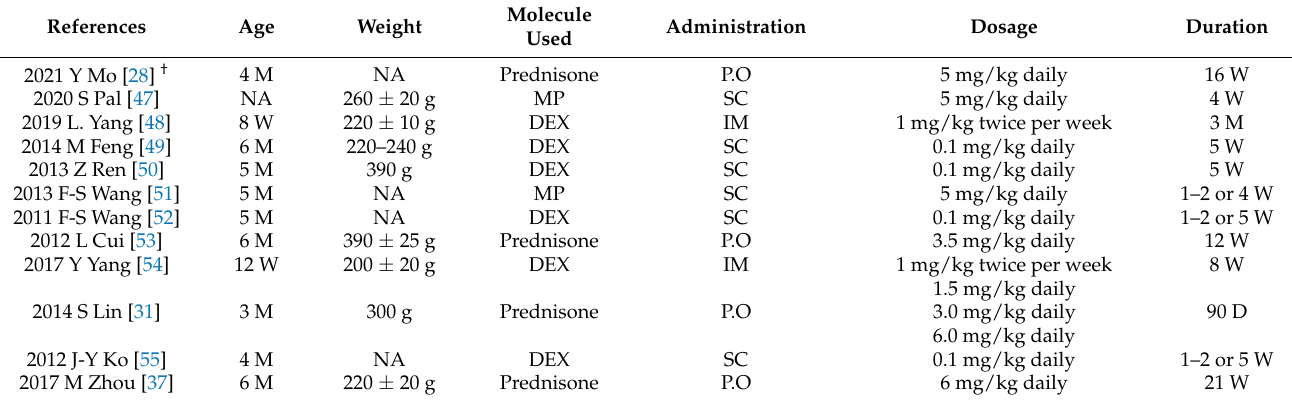
Table 4. Main characteristics of the proposed experimental protocol to induce GIOP in male Sprague Dawley. DEX = Dexamethasone, MP = Methylprednisolone, IM = Intramuscular injection, SC = Subcutaneous injection, P.O = Per. Os, NA = Not Available, † Study using mice and Sprague Dawley rats.